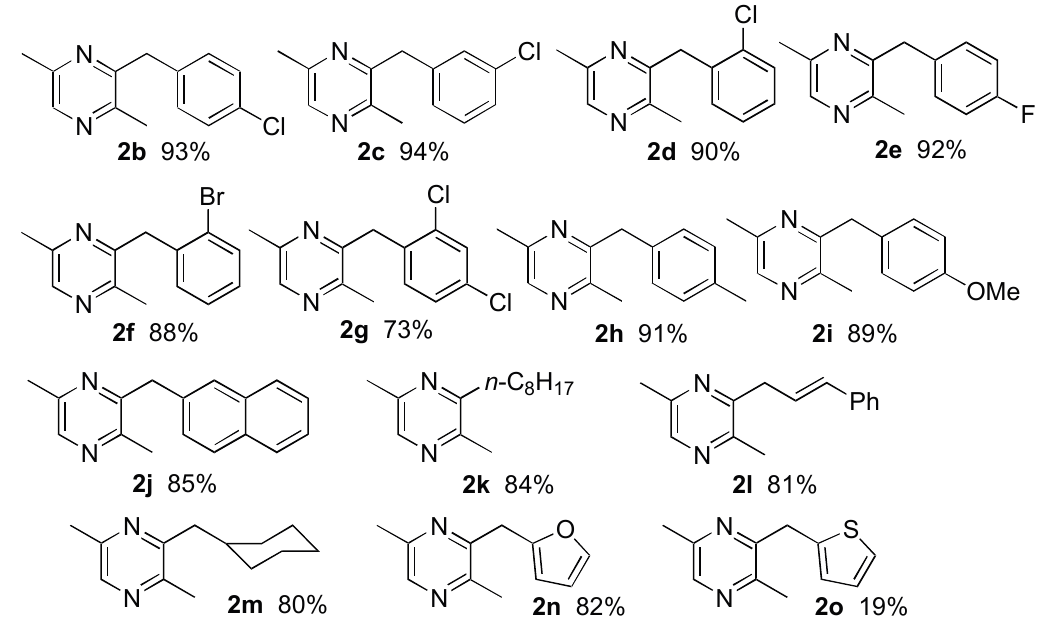
Table 2. Synthesis of 2,5-dimethylpyrazine derivatives a